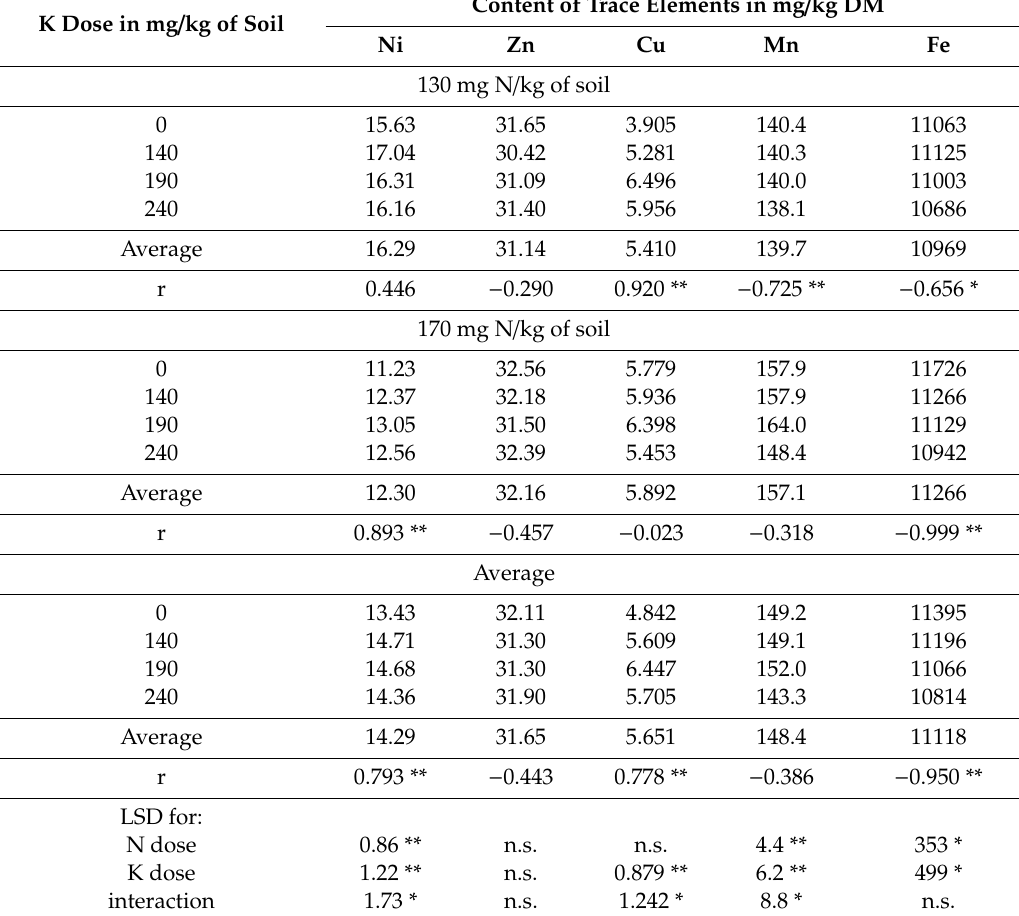
Table 3. Content of nickel (Ni), zinc (Zn), copper (Cu), manganese (Mn), and iron (Fe) in soil (mg / kg DM).